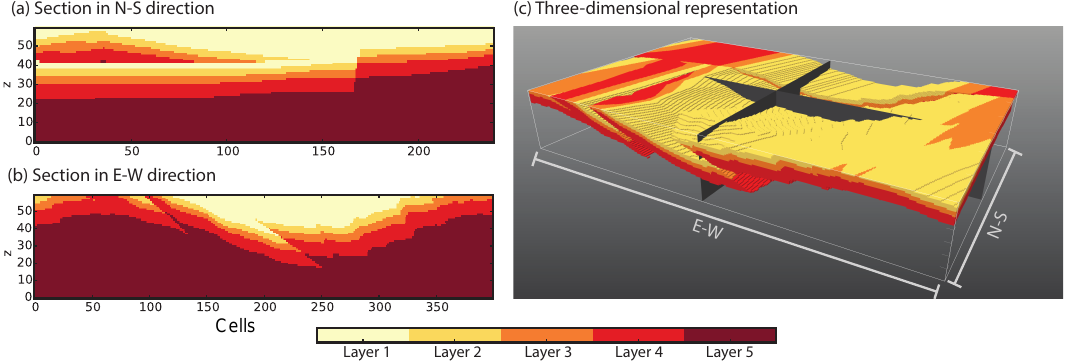
Figure 4. Sections through the fold and thrust belt model in (a) north–south direction, and (b) east–west direction (vertical exaggeration of 1.5) through the centre of the model. (c) Three-dimensional representation for the central three layers of the fold and thrust belt model. The grey surfaces correspond to the location of the sections in the figure above.